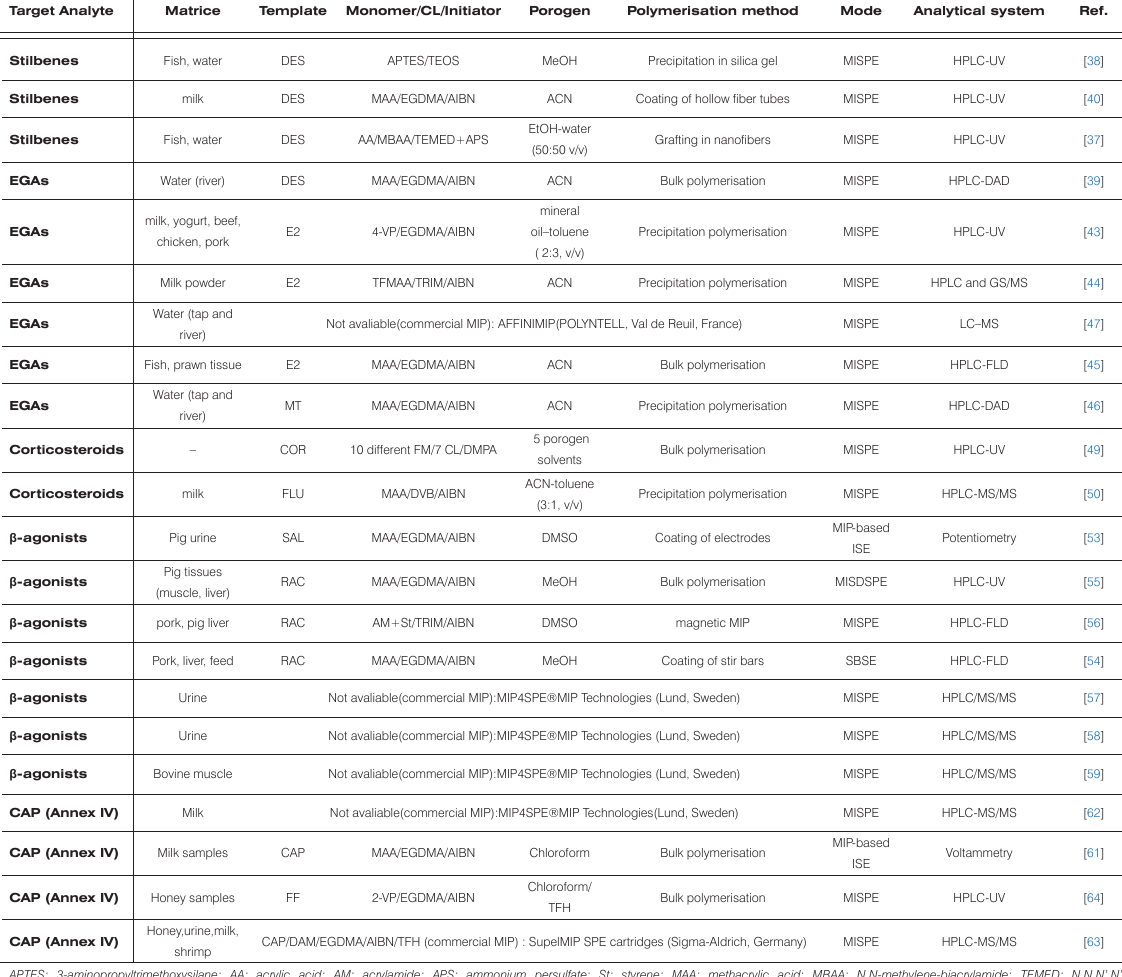
Table 1. Application of molecularly imprinted technology to the analysis of group A substances (Council Directive 96/23/EC) in